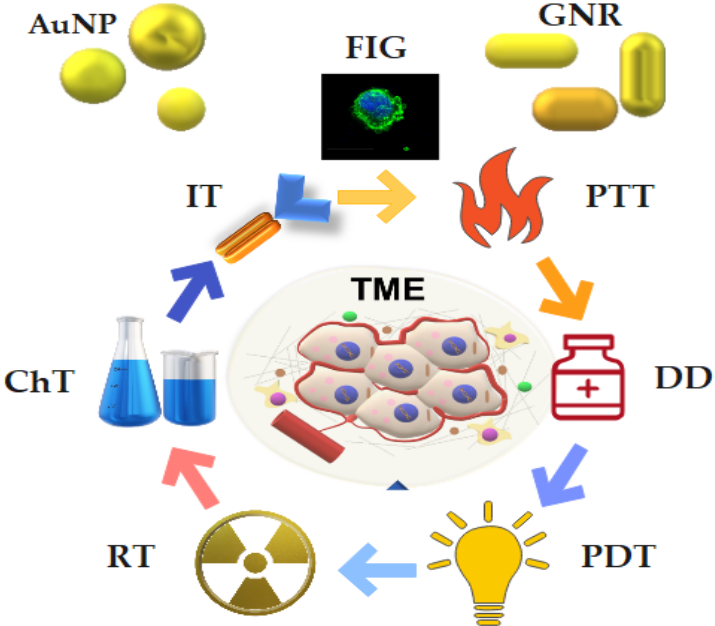
Figure 8. Theranostic applications of gold nanoparticles . AuNPs used for biomedical applications are sphere-shaped (AuNP) and rod-shaped (GNR). TME = tumor microenvironment; RT = radiotherapy; PTT = photothermal therapy; PDT = photodynamic therapy; IT = immunotherapy; ChT = chemotherapy; DD = drug delivery; FIG = fluorescence image-guided therapy.